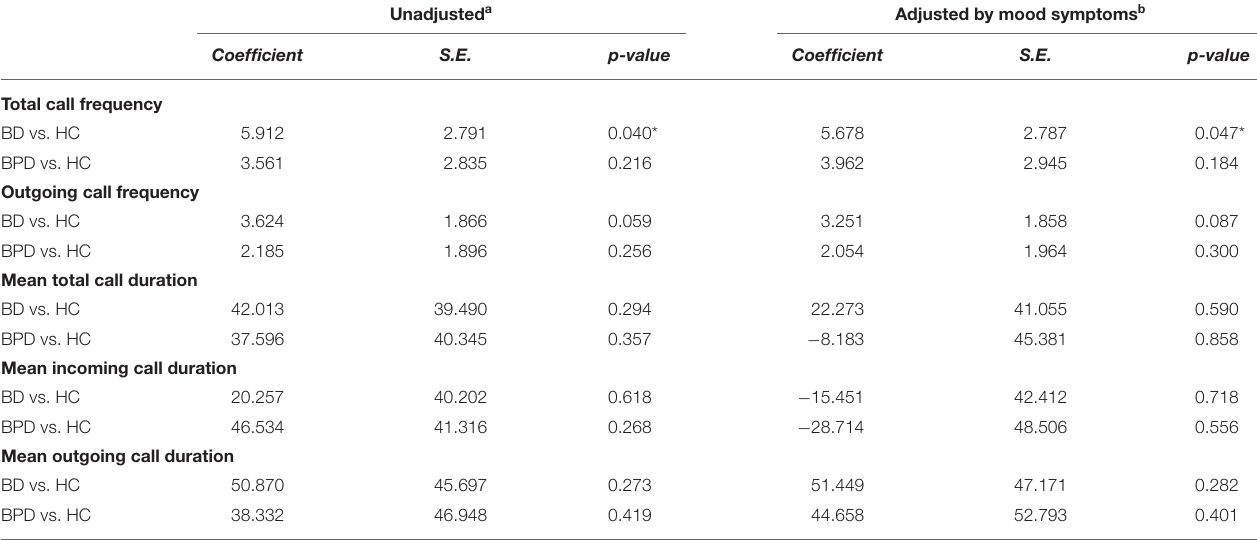
TABLE 4 | Phone call data by diagnosis (adjusted by mood symptoms).